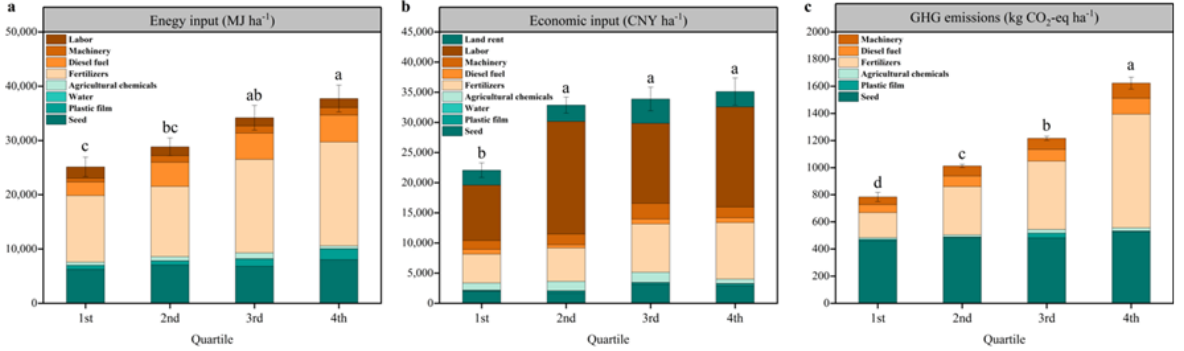
Figure 4. The means of energy inputs ( a ), economic inputs ( b ), and GHG emissions ( c ) per hectare in the sweet potato production of the four quartiles (1st, 2nd, 3rd, and 4th quartiles). The different lowercase letters indicate significant differences within the four quartiles at the p < 0.05 level. Bars represent standard errors.